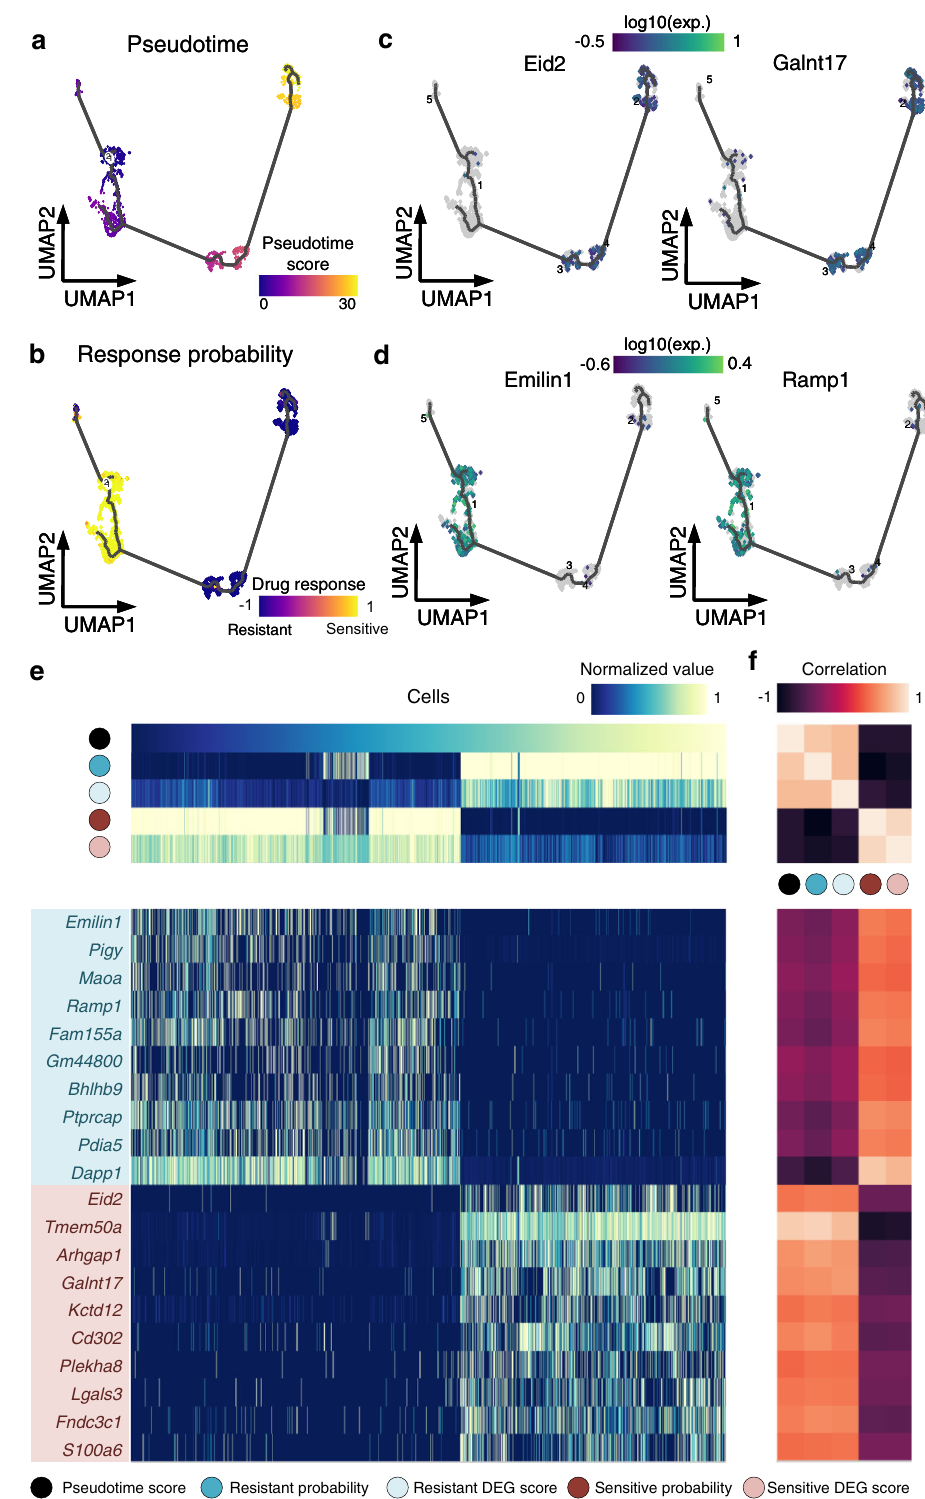
Fig. 5 | Validating predicted drug response with pseudotime trajectory. a Cell UMAP plot colored as per pseudotime scores predicted from the raw scRNA- seq data(Data 6). b Same UMAP plotcolored as per predicted continuousdrug response probability scores in scDEAL. c , d Diffusion UMAP colored by gene expressions of two representative genes in the predicted sensitive CG list and resistant CG list, respectively. e , f DEG scores in the sensitive and resistant